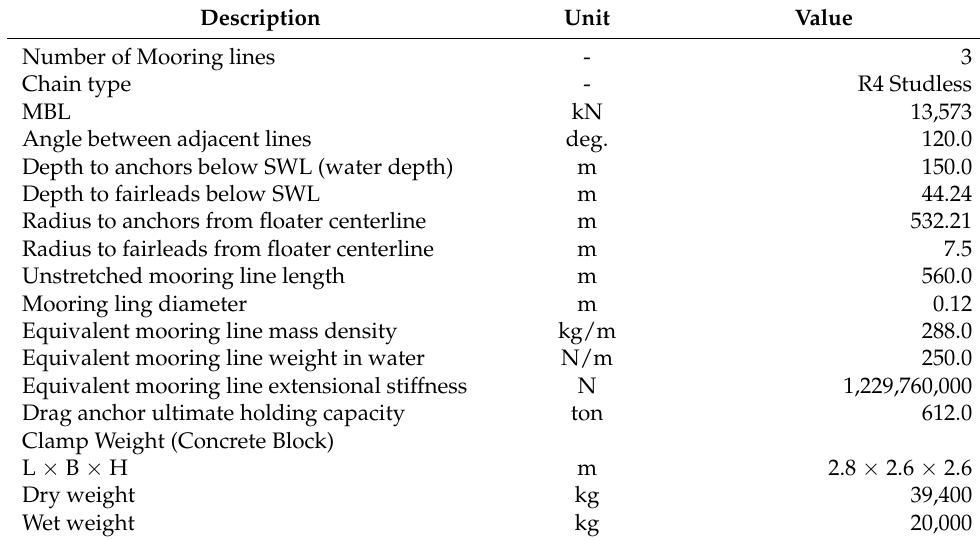
Figure 4. Baseline configuration of the mooring system. Table 4. Mooring system properties.